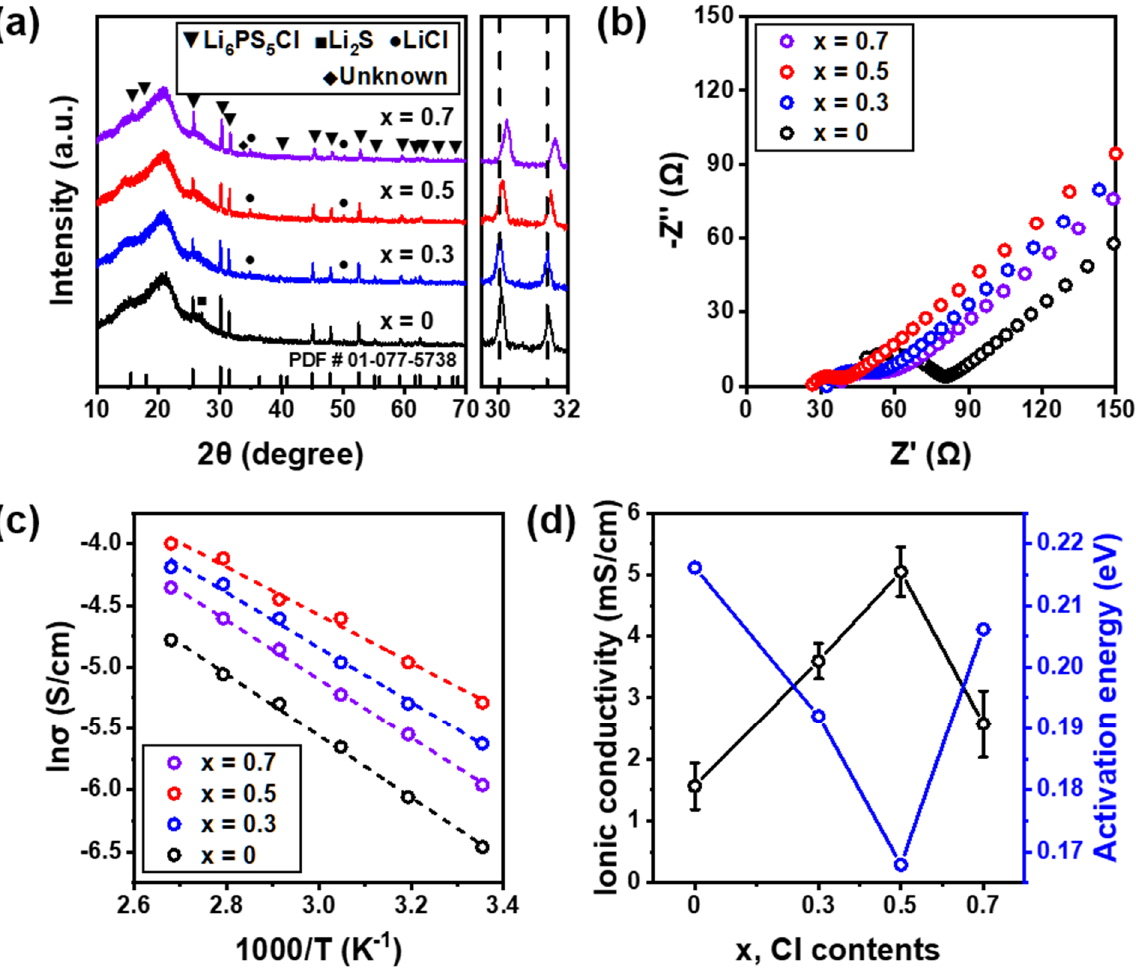
Figure 1. ( a ) XRD patterns of Li 6−x PS 5−x Cl 1+x (0 ≤ x ≤ 0.7) electrolytes. ( b ) Nyquist plots of Li 6−x PS 5−x Cl 1+x (0 ≤ x ≤ 0.7) electrolytes measured at 25 °C. ( c ) Arrhenius plots of Li 6−x PS 5−x Cl 1+x (0 ≤ x ≤ 0.7) electrolytes measured in the range of 25 to 100 °C. ( d ) Activation energy (E a ) and ionic conductivity of Li 6−x PS 5−x Cl 1+x (0 ≤ x ≤ 0.7) electrolytes as a function of the Cl content. The Nyquist plots of Li 6−x PS 5−x Cl 1+x (0 ≤ x ≤ 0.7) electrolytes measured at 25 °C are